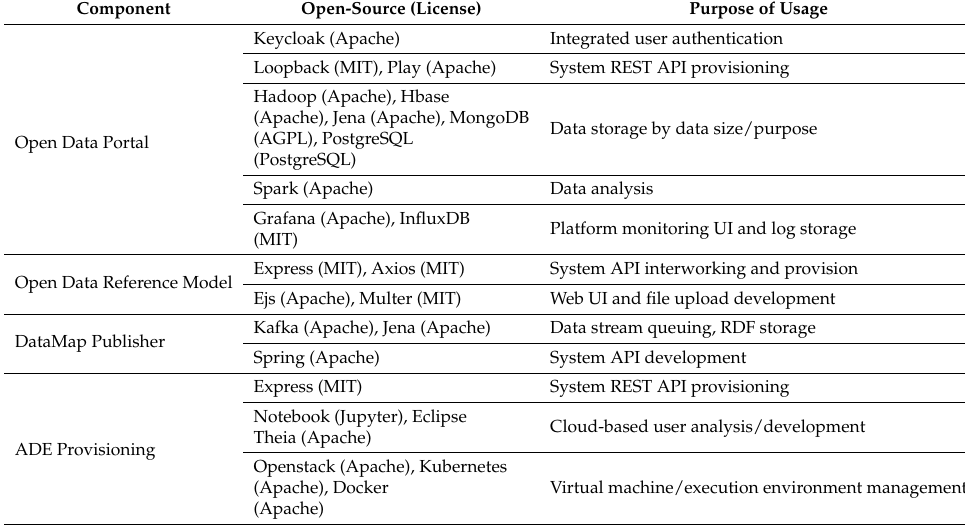
Table 4. Implementation environments of